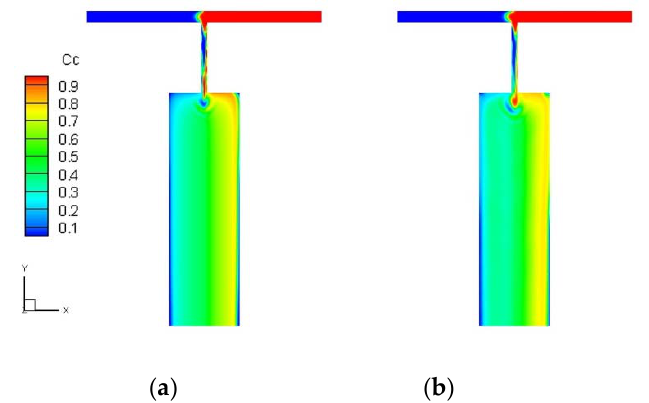
Figure 5. Concentration distribution in the Newtonian fluid case ( a ) and viscoelastic fluid case ( b ) under modulated pressure at the inlet I 1 and constant pressure at the inlet I 2 .